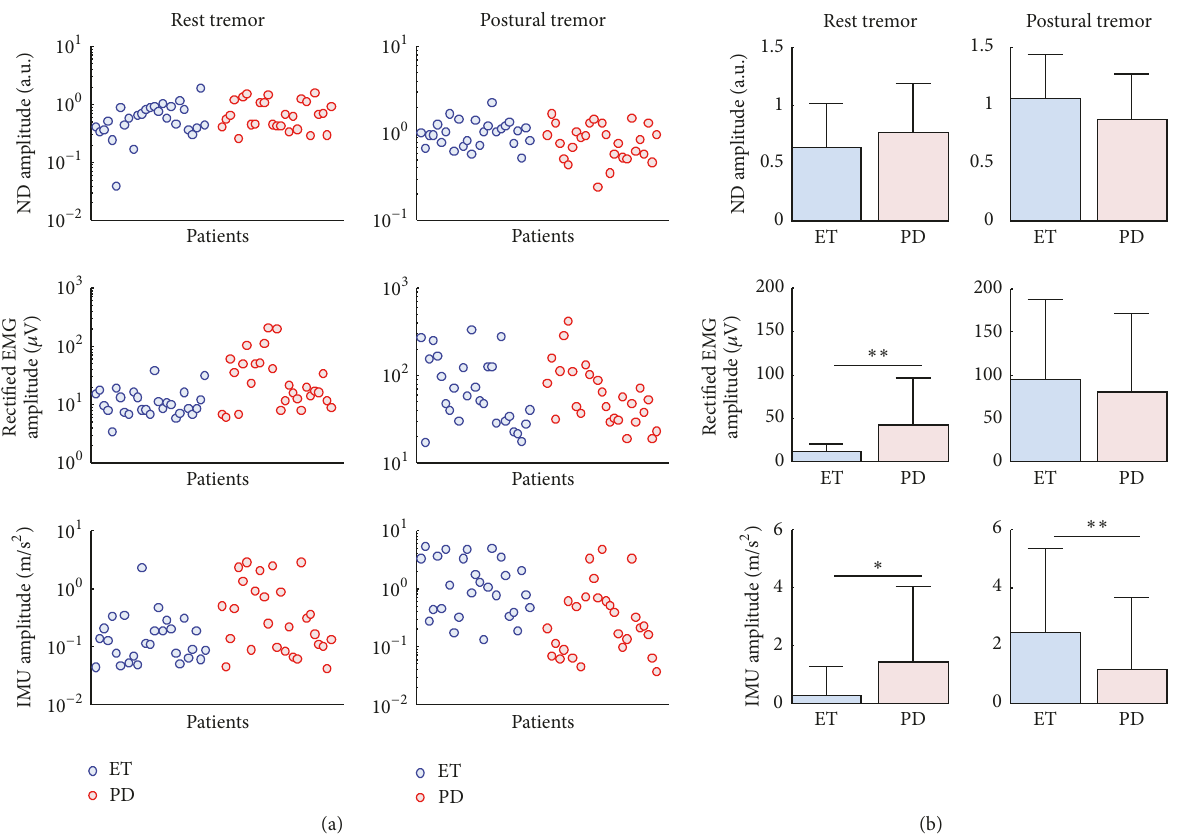
Figure 6: (a) Average amplitude of the rest and postural tremor in 54 ET and PD patients, as computed from the following: top: the neural drive (ND); middle: the spatial average of all the rectified EMG channels per muscle (EMG); and bottom: accelerometers (IMU). Tremor amplitude was assessed from the most affected muscle (ND and EMG) and from dominant tremor site (IMU). Each dot in the scatter plots represents one patient. The amplitude of the neural drive is expressed in arbitrary units (a.u.; see text). (b) Statistical comparison of the three different tremor amplitude estimates across ET and PD patients. ∗ 𝑝 < 0.05 and ∗∗ 𝑝 < 0.01 denote statistically significant difference as assessed by Kruskal-Wallis